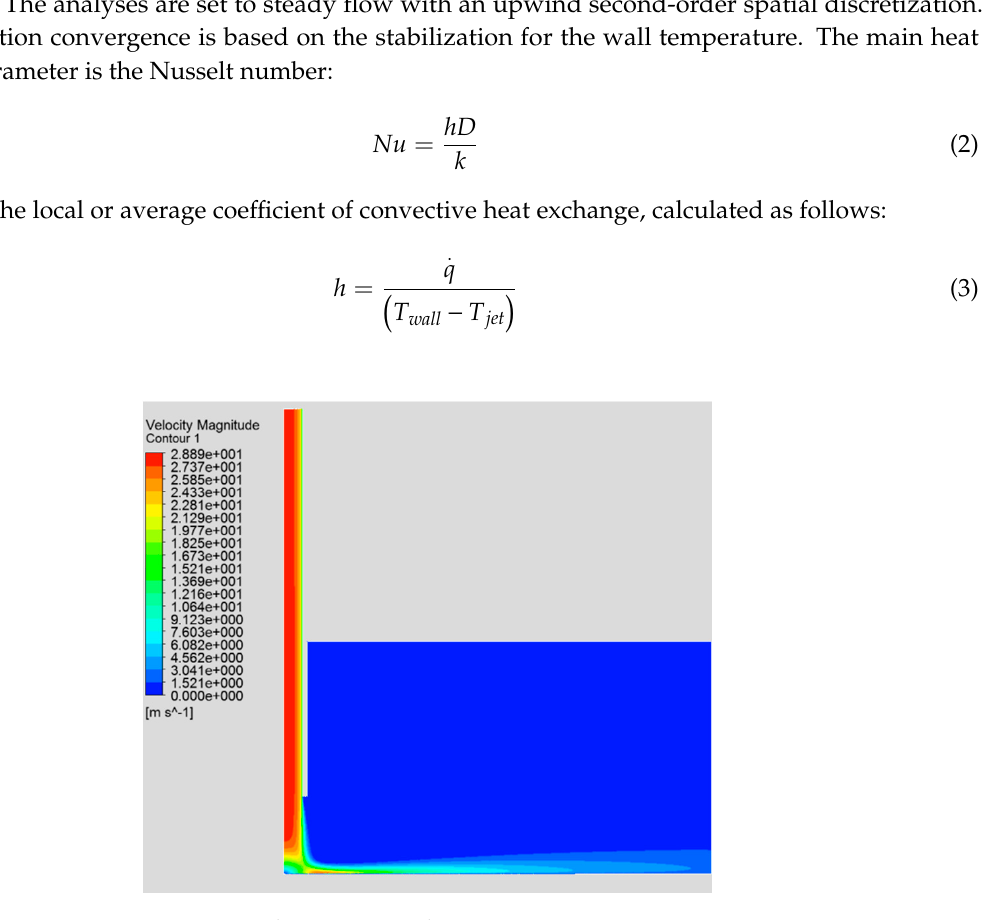
Figure 2. Velocity magnitude contours in case H/D = 2.